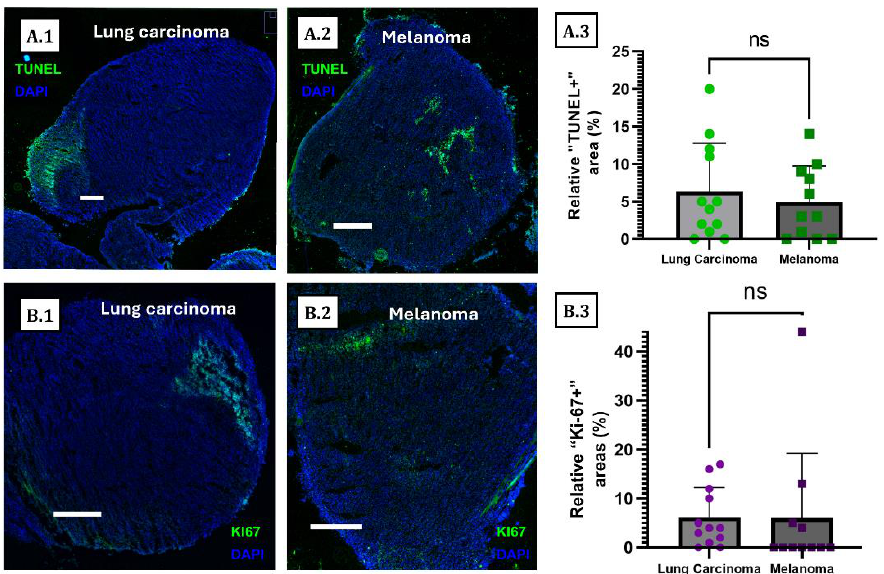
Figure 6. ( A.1 , A.2 ) Tumor necrosis (TUNEL) and ( B.1 , B.2 ) proliferation (Ki67) of CAR and MEL macrometastases. TUNEL+ and Ki67+ areas were selected and quantified by normalizing the total tumor area to 100% (( A.3 , B.3 ), respectively). Scale bar = 500μm .